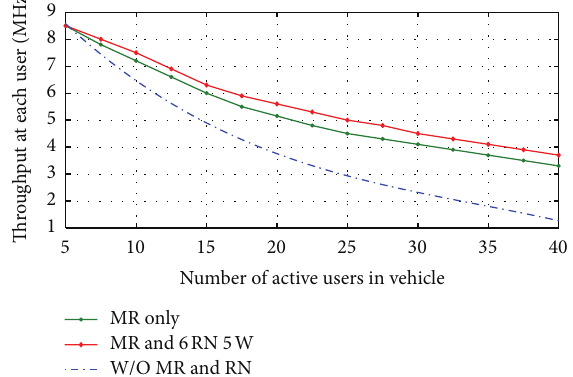
Figure 10: Throughput enhancement at users inside